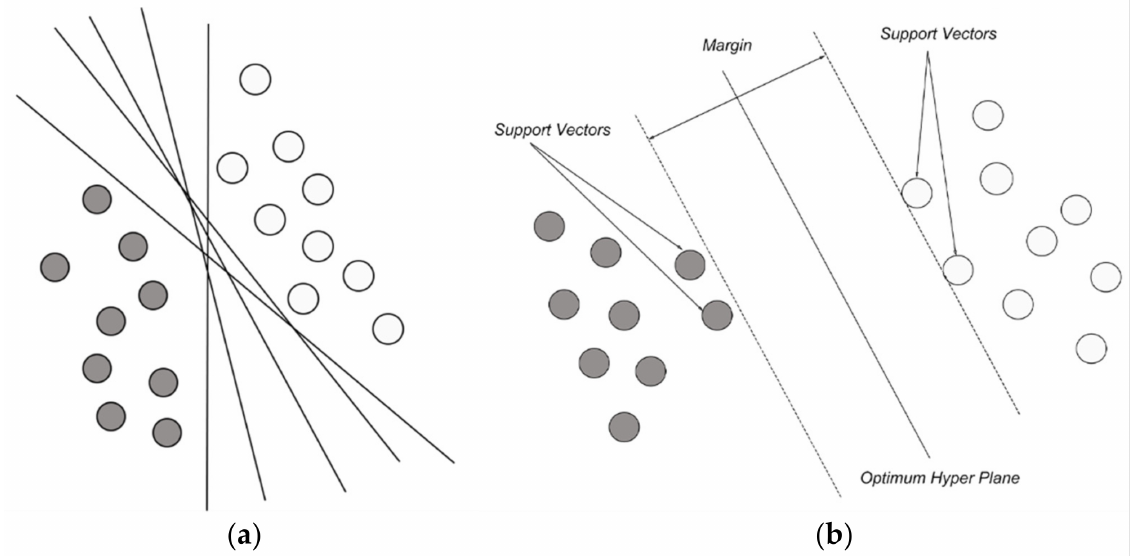
Figure 4. ( a ) Hyperplane of linearly separable data; ( b ) optimum hyperplane and support